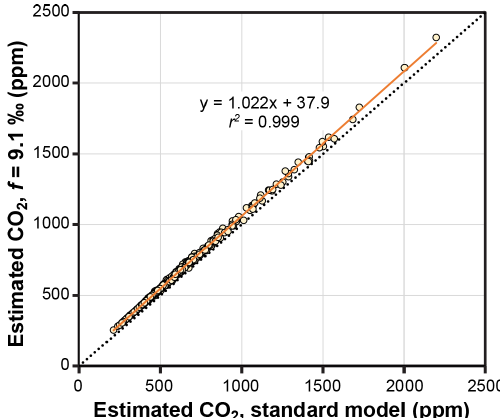
Figure 6. Estimates of CO 2 with and without a photorespiration effect ( f = 9 . 1‰; see Eq. 10). Each symbol is an extant or fossil leaf. Dashed line is y = x